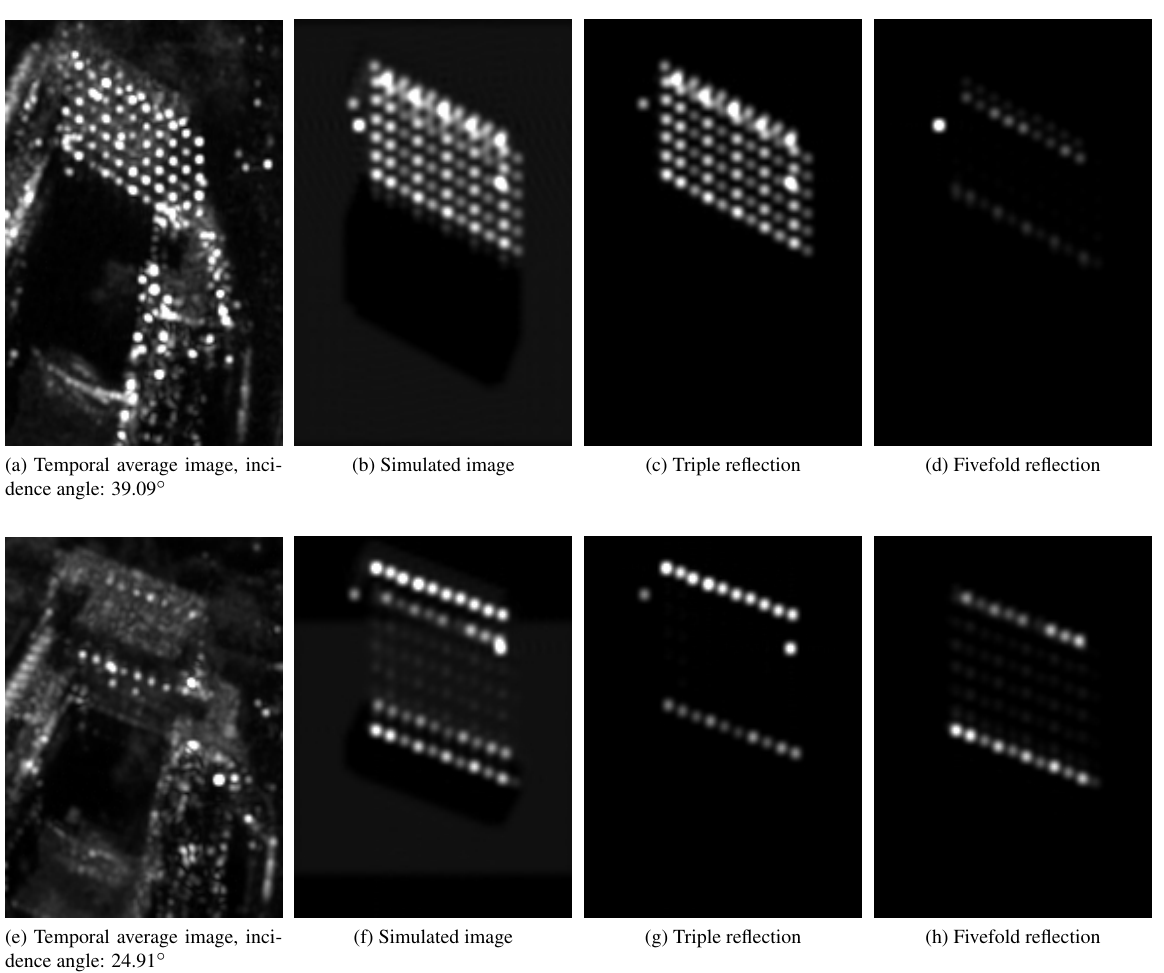
Figure 4: Comparison of TerraSAR-X temporal average images with simulated images and relevant image layers related to different reflection levels. Azimuth: left to right. Range: